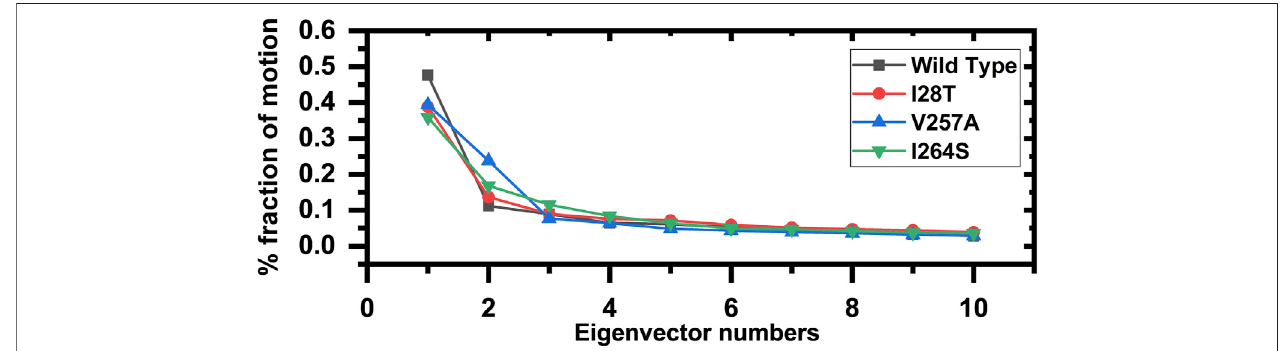
FIGURE9| Principalcomponentanalysisofallthesystems,includingtheWTandthethreemutants.The fi rsttwoprincipalcomponents(PC1andPC2)areusedfor the projection of motion in the space phase at 300 K.